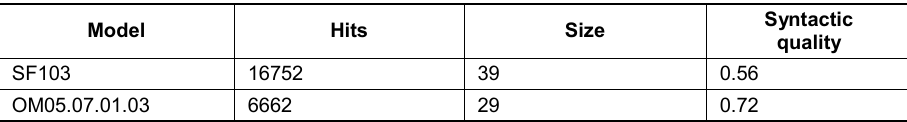
Table 3. Characteristics of workflow models used in the